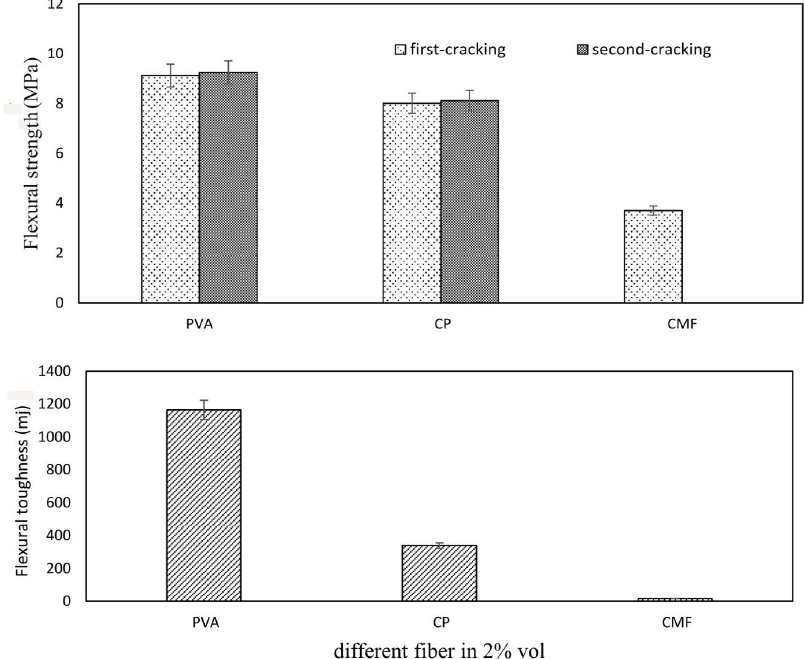
Fig. 9. Flexural properties of different cement composites containing 2 vol%